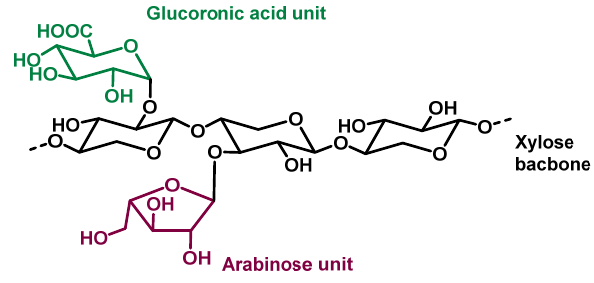
Figure 18. Xylan-type